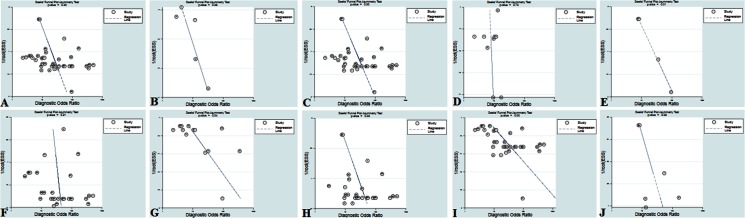
Funnel plot for the assessment of potential publication bias.The funnel graphs plot the square root of the effective sample size (1/ESS1/2) against the DOR. Each circle represents each study in the meta-analysis. Asymmetry of the circle distribution between regression lines indicates potential publication bias. (A) TmiRs pooled result, (B) miR-21 pooled result, (C) TmiRs-KO-21 pooled result, (D) PBMC pooled result, (E) serum pooled result, (F) plasma pooled result, (G) Caucasian pooled result, (H) Mongoloid pooled result, (I) SLE sample size (n < 100) pooled result, and (J) SLE sample size (n ≥ 100) pooled result. This funnel plot indicates no publication bias with a P value >.05. DOR = diagnostic odds ratio, ESS = effective sample size, miR = mircoRNA, TmiRs = total mixed miRNAs, TmiRs-KO-21 = total mixed miRNA knock out miR-21, SLE = systemic lupus erythematosus, PBMC = peripheral blood mononuclear cell.